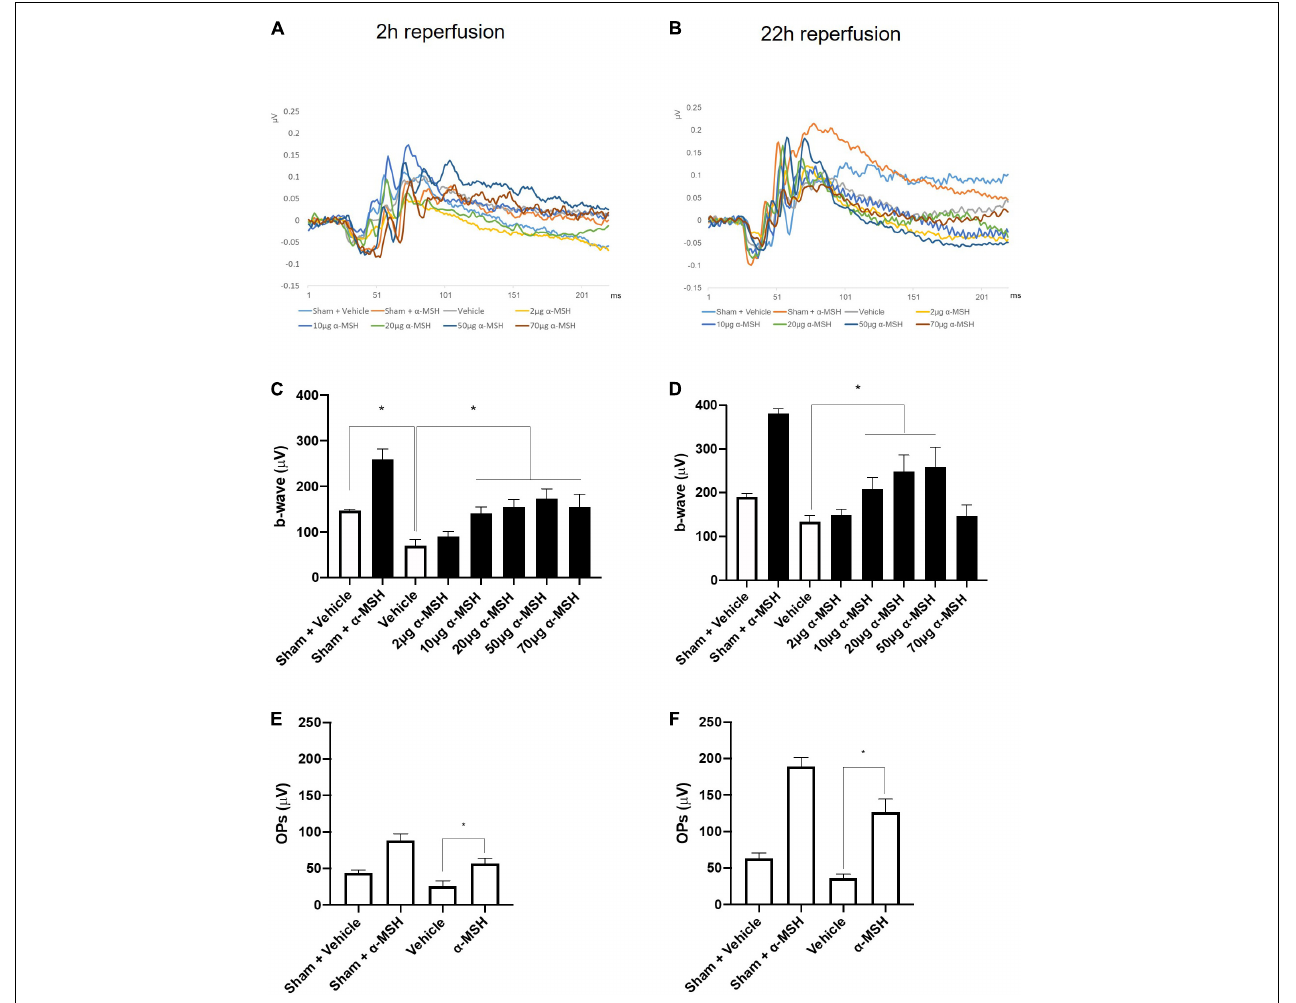
FIGURE 1 | α -MSH preserved the retinal function after I/R injury. (A) Representative ERG waves at 2 h of reperfusion. (B) Representative ERG waves at 22 h of reperfusion. (C) The amplitude of b-wave was significantly higher in animals treated with 10, 20, 50, and 70 µ g of α -MSH at 2 h of reperfusion. (D) This amplitude was significantly higher in animals treated with 10, 20, and 50 µ g of α -MSH at 22 h of reperfusion. One-way ANOVA followed by Dunnett test. (E,F) OPs were significantly higher in α -MSH (50 µ g) treated animals in both experimental conditions. One-way ANOVA followed by Tukey’s test. Flash 3 (P)cd.s/m 2 . * P < 0.05, n = 5–6 for each